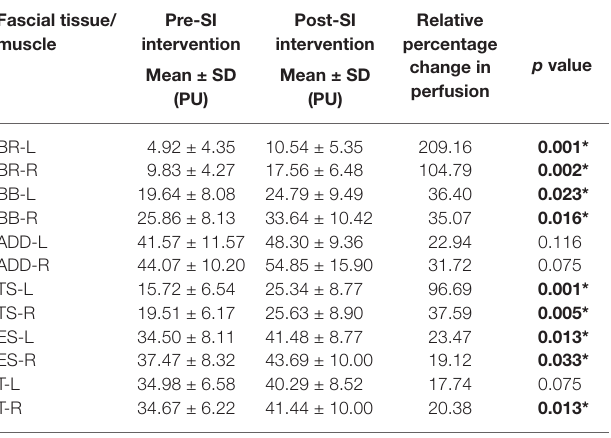
TABLE 2 | The intragroup analysis of the superficial blood perfusion results. Fascial tissue/